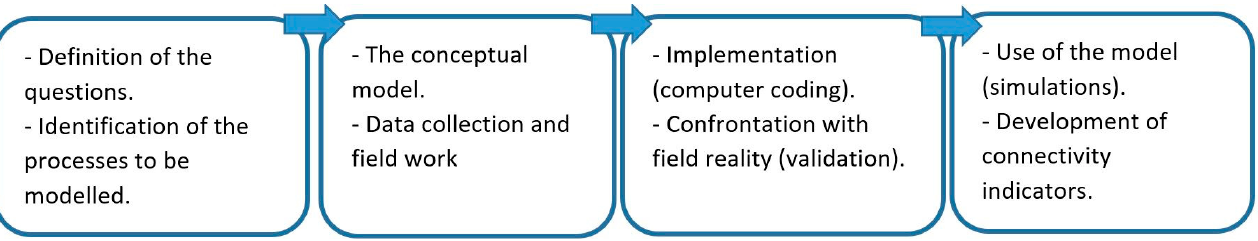
Figure 1. Flow chart of research steps.